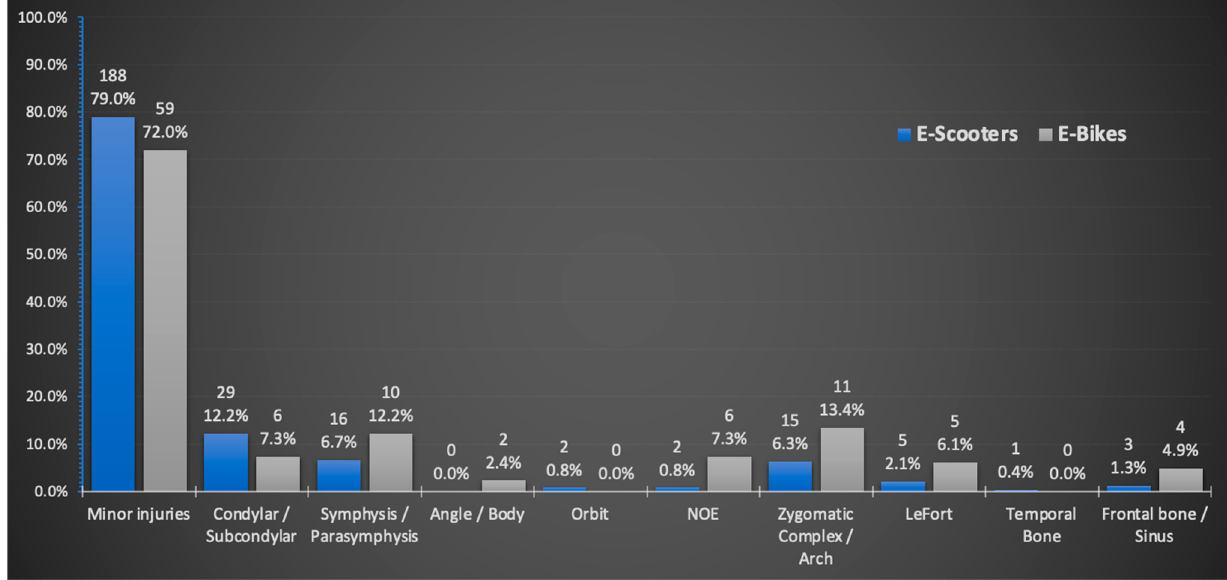
Figure 1. Distribution of injuries among E ‐ scooters’ and E ‐ bikes’ riders.